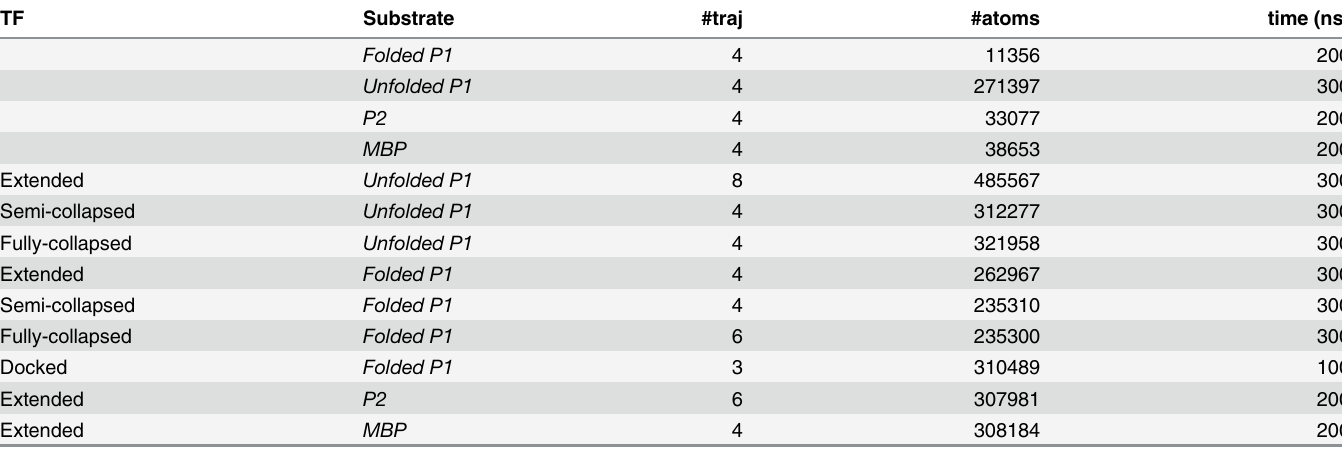
Table 1. MD systems